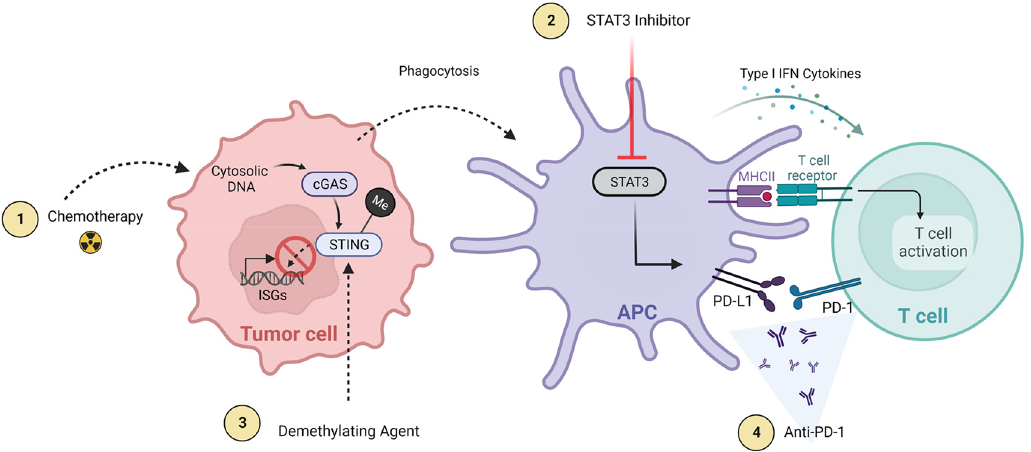
Figure 3. Major STING combinatorial approaches with additive or synergistic effects. 1) Radiation/chemother- apy and 2) demethylation agents that enhance downstream STING activation either through increasing cytoplasmic DNA (radiation) or decreasing STING promoter methylation (demethylating agents). Other immunotherapies (3 and 4) are synergistic therapies that focus on increasing net STING function and antitumor response through either decreasing anti-inflammatory cytokines (STAT3 inhibition) that at baseline thwart STING response or decreasing T cell deactivation and exhaustion (anti-PD-1/PD-L1). Created with